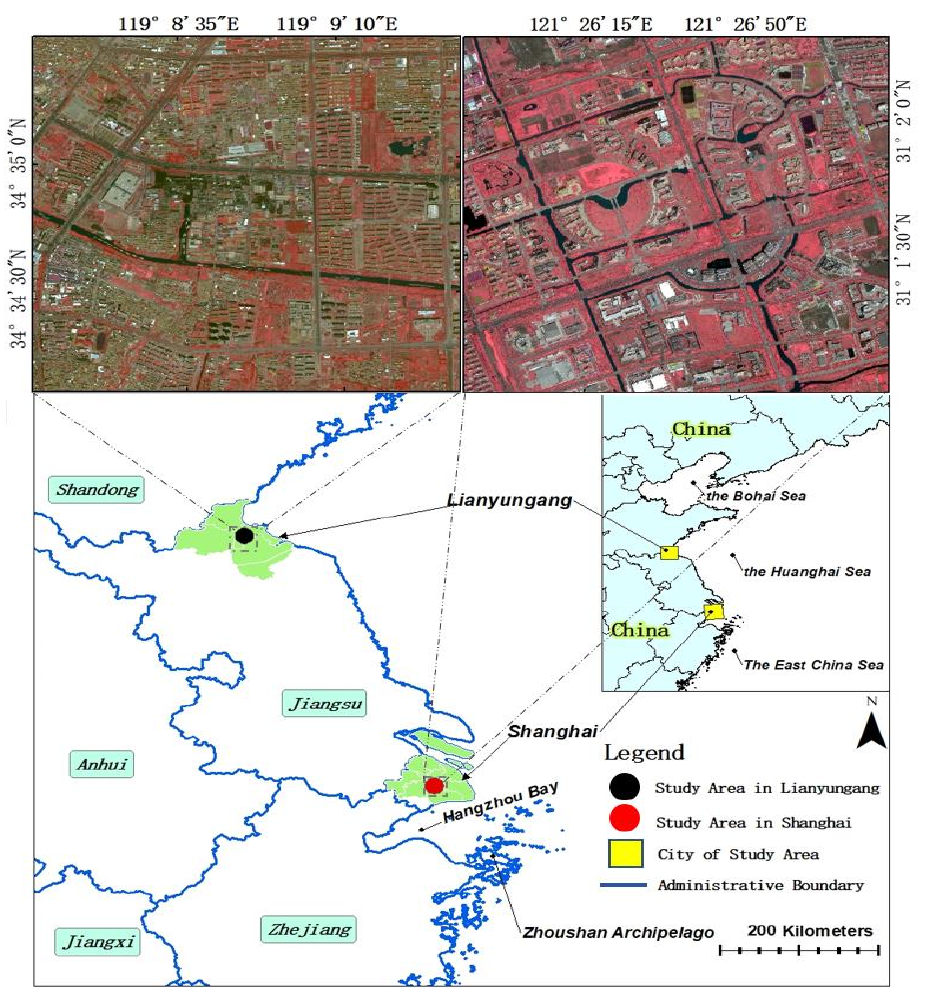
Figure 2. The location of the study area in Shanghai and Lianyungang, China.